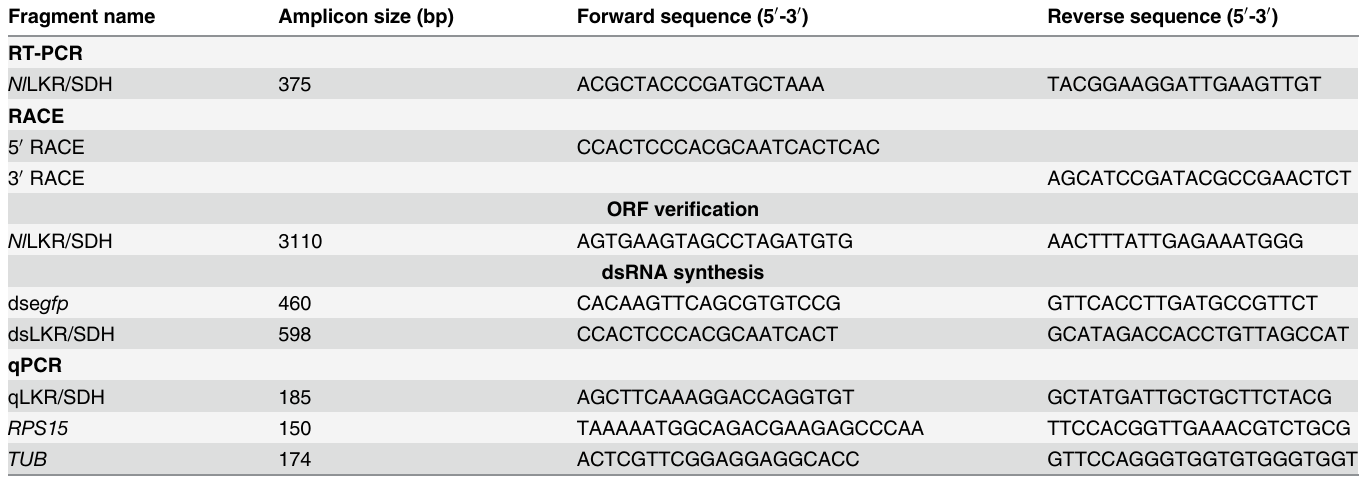
Table 2. Primers used for RT-PCR, RACE, dsRNA synthesis and